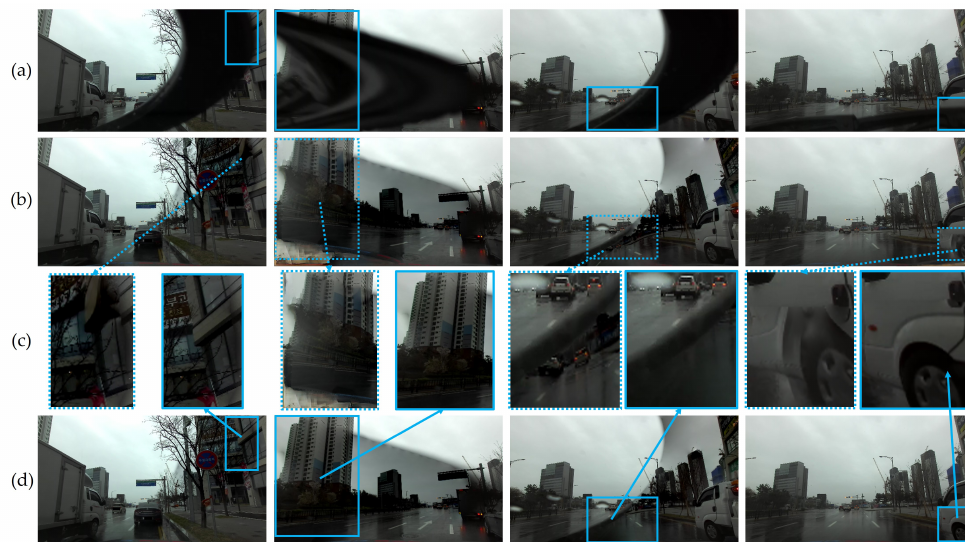
Figure 13. Image restoration results: ( a ) original images; ( b ) restored results with masks from raft- things; ( c ) comparisons between raft-things and BTS; ( d ) restored results with masks from BTS. The results demonstrate the importance of mask accuracy by reducing artifacts in the restored regions in ( c ), such as distorted buildings (1st and 2nd row), mirrored objects (3rd row), and a blurred vehicle wheel (4th row), as shown in the red boxes. Best viewed with